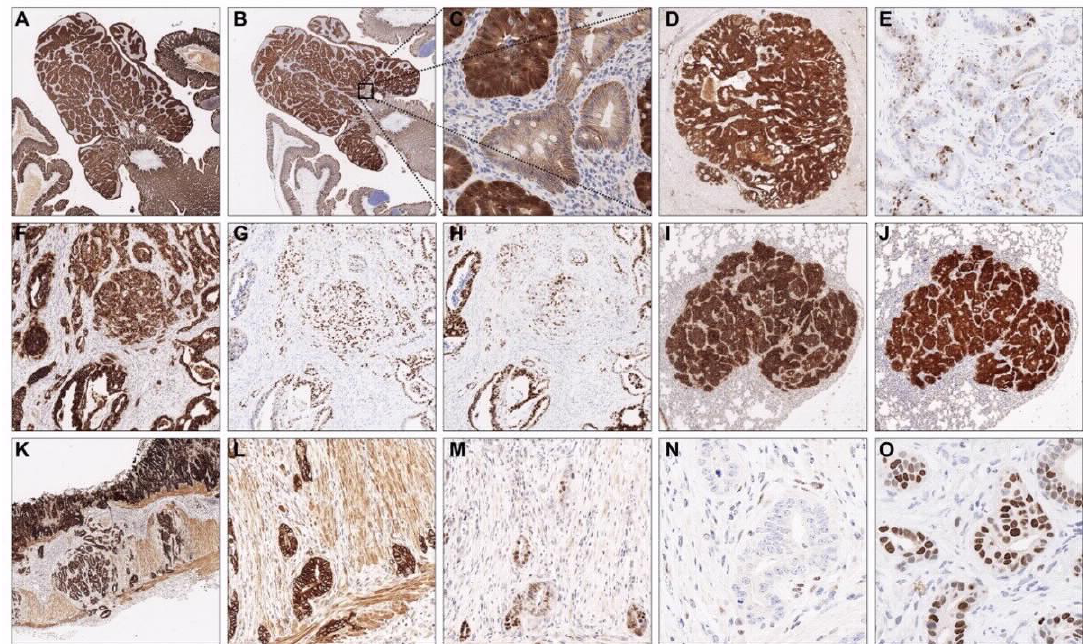
Figure 3. Immunohistochemical analysis confirms the colorectal origin of the tumors and metastases. ( A – C ) EPCAM (( A ), 2×) and β-catenin (( B ), 2×) expression in a tubular adenoma (Apc). Note the accumulation of β-catenin in neoplastic glands as compared to non-transformed glands (( C ), 20×). ( D , E ) EPCAM (( D ), 4×) and CDX2 (( E ), 4×) expression demonstrate the colorectal origin of liver metastasis (AK). ( F – H ) Invasive tumor cells in an AKPr mouse: EPCAM (( F ), 10×), P53 (( G ), 10×) and CDX2 (( H ), 10×). ( I , J ) EPCAM (( I ), 4×) and β-catenin (( J ), 4×) positivity confirm a colorectal lung metastasis (AK). ( K – M ) AKPfl tumor penetrating the muscularis propria: EPCAM, (( K ) (4×), ( L ) (20×)), CDX2 (( M ), 20×). ( N , O ) Loss of P53 expression in AKPfl (( N ), 40×) and nuclear accumulation of P53 in AKPr (( O ), 40×) in direct comparison. Apc, Apc fl/fl mice; AK, Apc fl/fl /Kras LSL-G12D/+ mice; AKPr, Apc fl/fl /Kras LSL-G12D/+ /Trp53 LSL-R172H/+ mice; AKPfl, Apc fl/fl /Kras LSL-G12D/+ /Trp53 fl /fl mice.